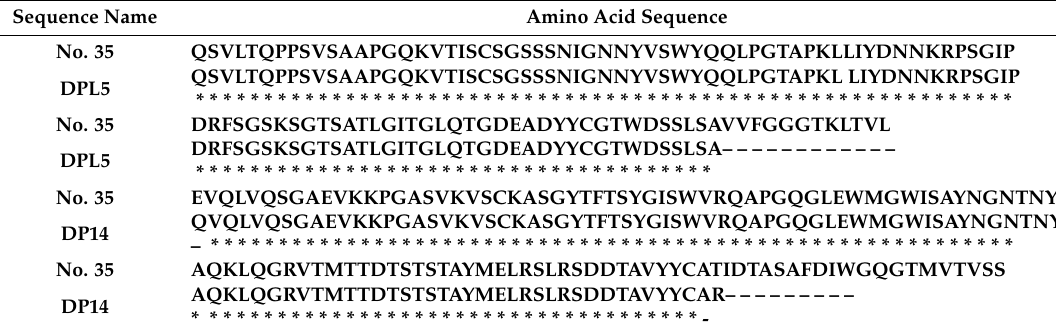
Table 2. Alignment of Amino Acid Sequences of anti-P-cadherin number 35 with variable light (VL)1 Germline 1b.366F5/DPL5...+. and variable heavy (VH)1 Germline DP-14/V1-18+. Star